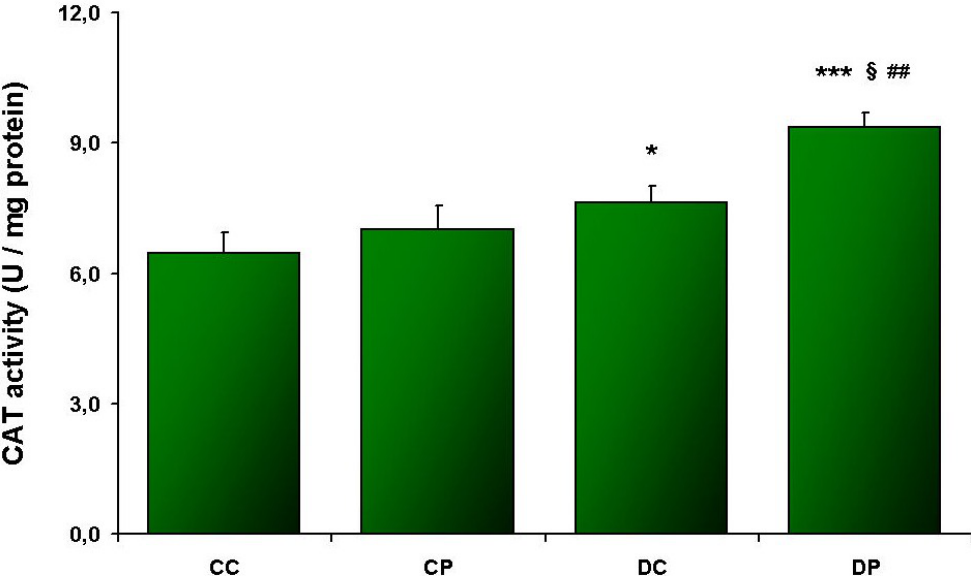
Figure 1. Catalase activity in SOL muscle; control diet (CC), control diet and EtP (CP), HFD (DC), HFD and EtP (DP). Values are means ± SE. * p < 0.05 as compared to CC; *** p < 0.005 as compared to CC; § p < 0.005 as compared to CP; ## p < 0.01 as compared to DC.